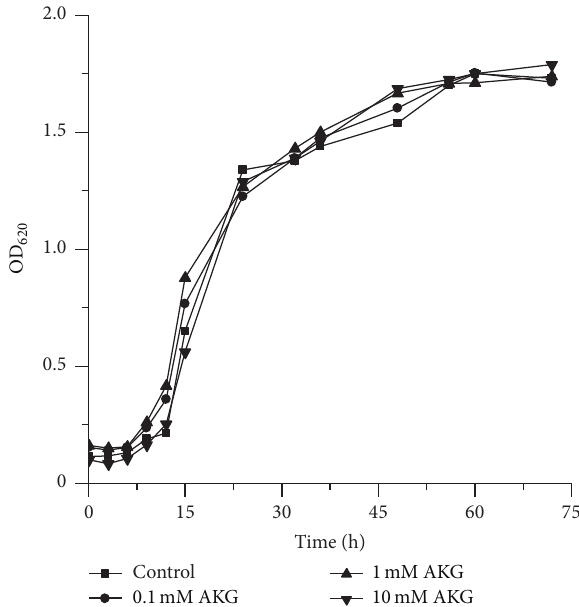
Figure 1: Growth curves of S. cerevisiae YPH250 in YPD medium in the presence of AKG at different concentrations. Growth was monitored by measuring the absorbance at 620 nm (OD 620